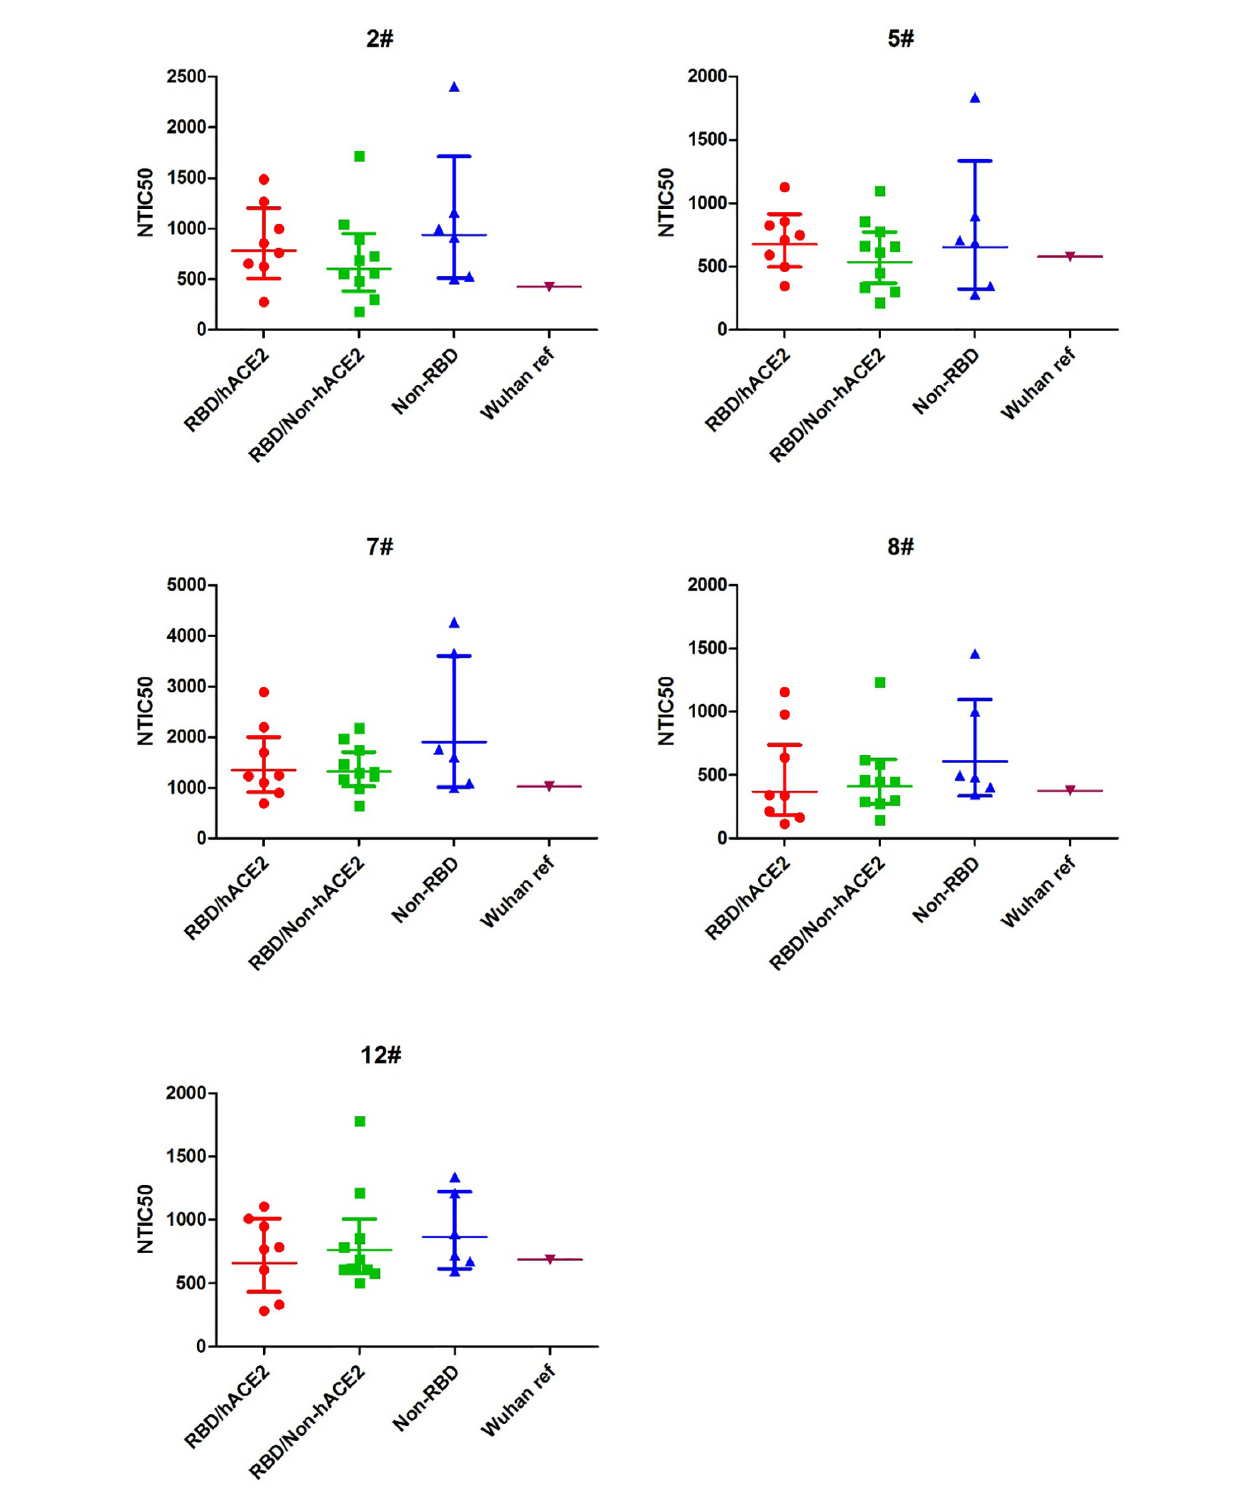
FIGURE 4 | NTIC50 against pseudovirus bearing the various spike mutants for the fi ve convalescent plasma samples (2#, 5#, 7#, 8#, and 12#) that show a higher neutralization titer against the Wuhan reference pseudovirus. The difference of GMT in different regions was tested for statistical signi fi cance with a Mann-Whitney U test in the GraphPad Prism